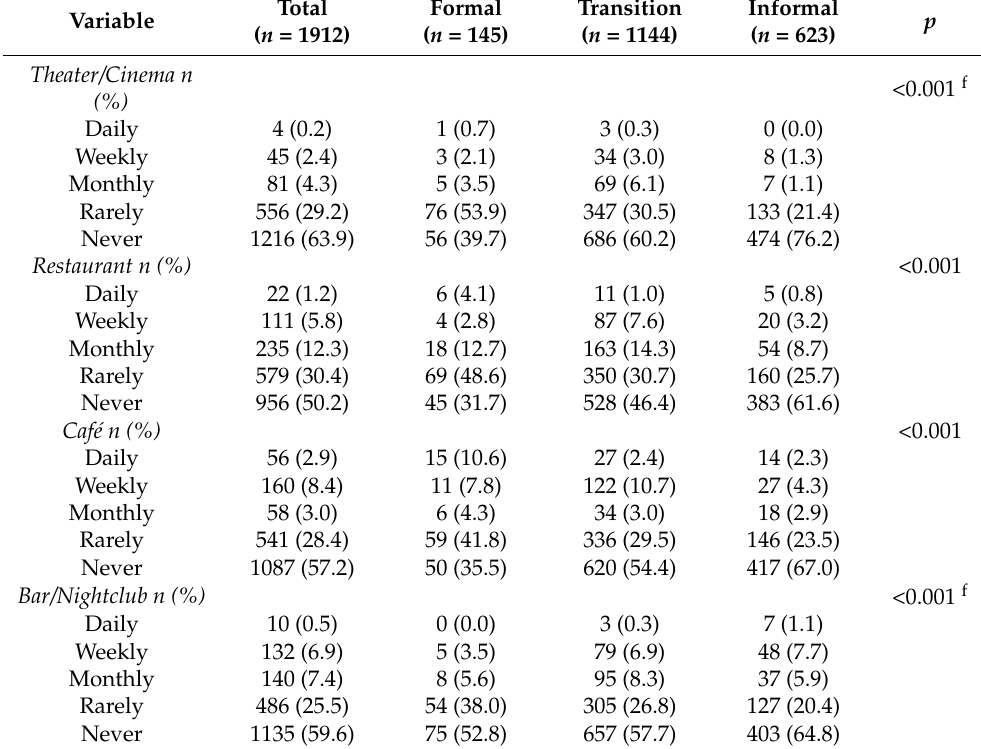
Table 2. Frequency of leisure/recreational activities by urban areas.